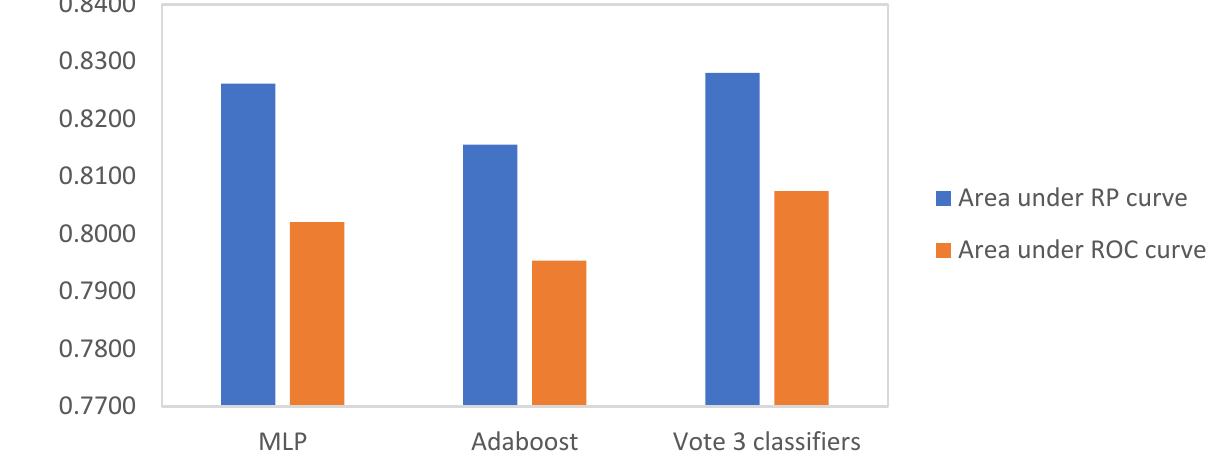
Figure 3. Area under RP curve and ROC curve for MLP, AdaBoost, and voting algorithm. The voting algorithm emerged as the superior classifier in comparison to MLP and AdaBoost, exhibiting the greatest AUC while achieving 78% accuracy, 64% recall, 88% precision, and 92% specificity. The results of the sensitivity analysis are summarized in Figure